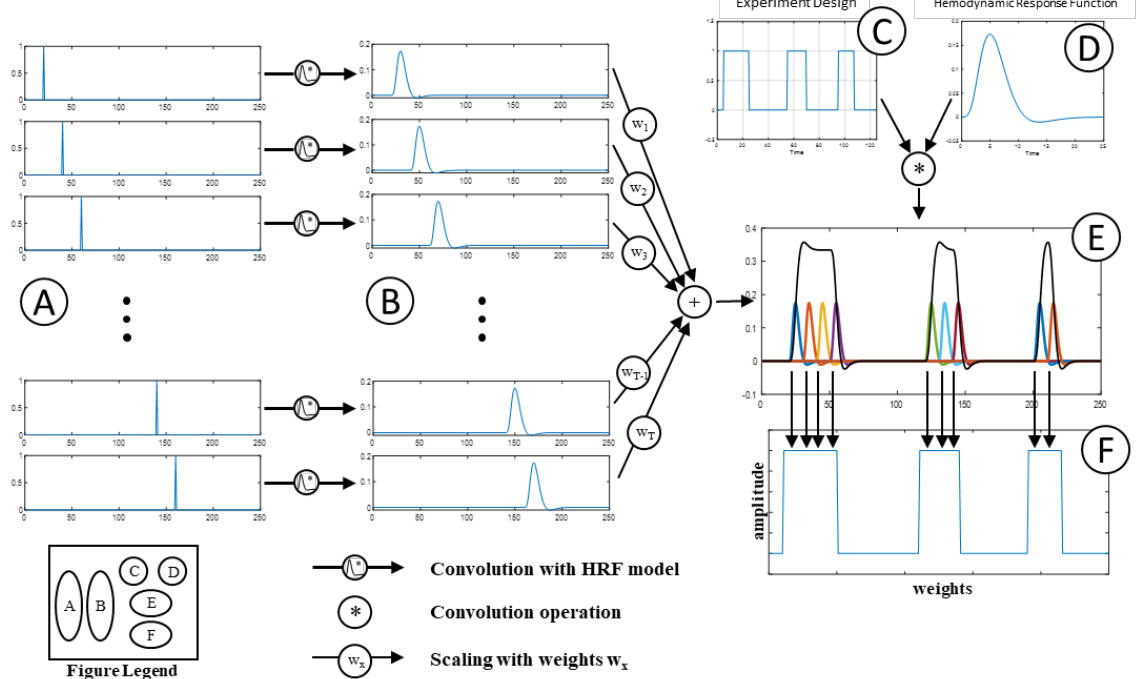
Figure 1. Summary of the algorithm for extraction of the pseudo-stimulus from given time series. ( A ) Train of impulses delayed in time. The time delay between each pair of impulse is equal to 1 TR. ( B ) The impulse train convolved with the HRF to give time-shifted hemodynamic responses. The time-shifted hemodynamic responses are used as regressors in the design matrix. ( C ) Typical fMRI experiment design. ( D ) Standard double-gamma hemodynamic response function (HRF). ( E ) Observed time series shown as the weighted sum of time-shifted hemodynamic responses. ( F ) The extracted pseudo-stimulus, obtained from the weights of the time-shifted hemodynamic